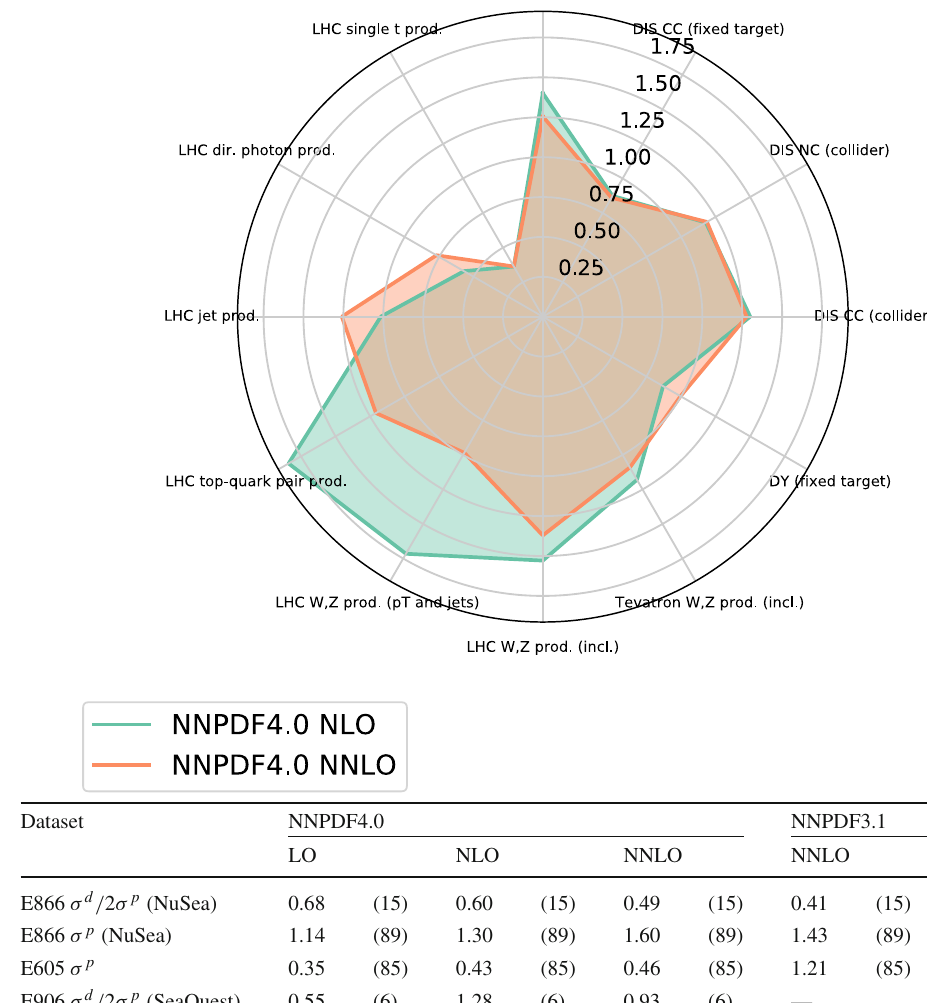
Fig. 16 Graphical representation of the results of Table 18, comparing the χ 2 of the NNPDF4.0 NLO and NNLO baseline fits